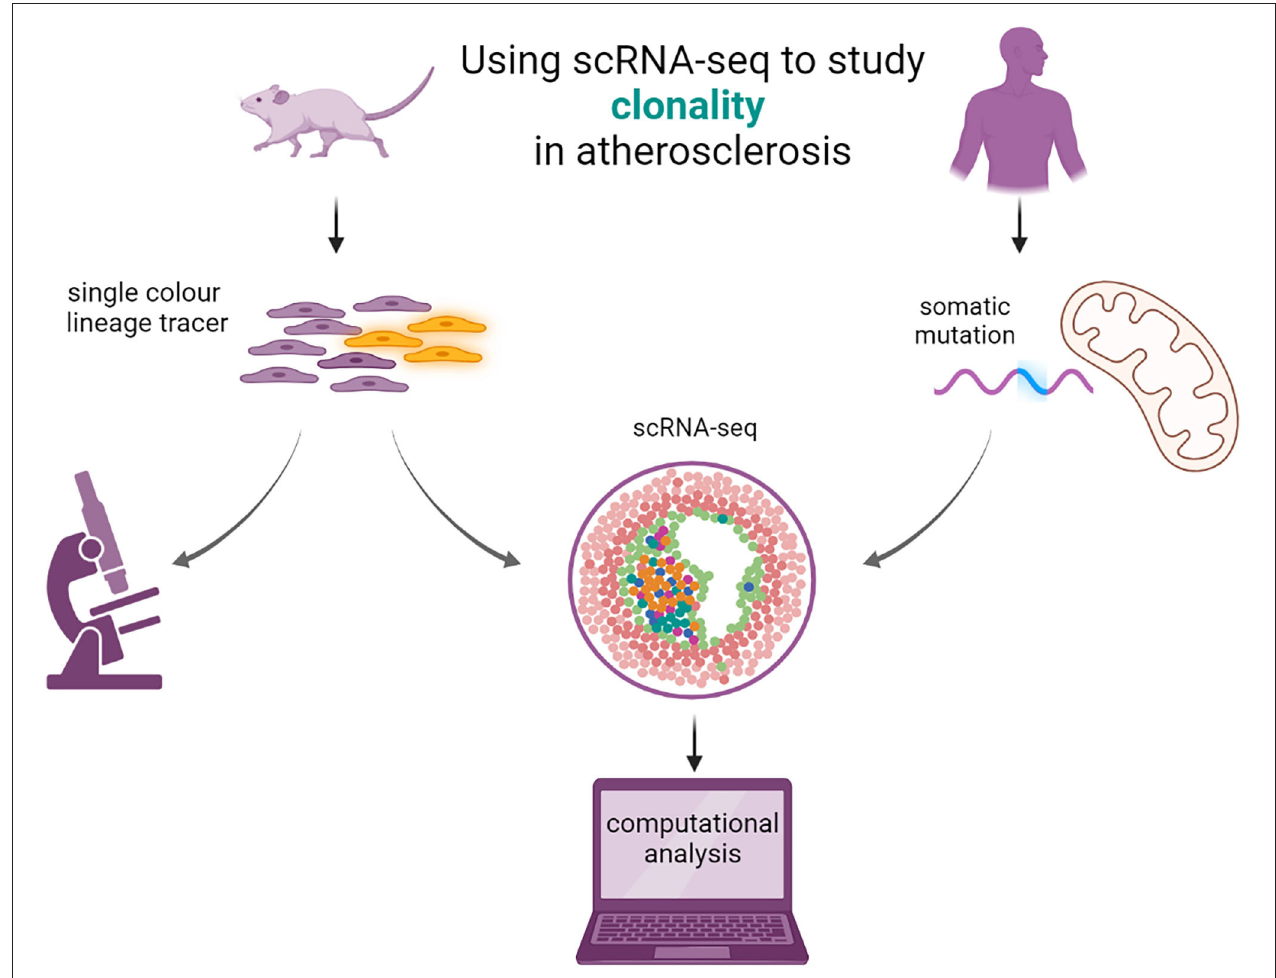
FIGURE 3 | Using scRNA-seq to study clonal cell expansion in atherosclerosis. Single color lineage tracers are added to reporter genes to study the clonality in mice (left). The mice will develop atherosclerosis and patches of clonal cells are visible from microscopy images. scRNA seq can be performed, and computational analysis can elucidate the transcriptomic properties of the cells expressing the lineage tracer. In humans (right), clonality can be imputed from studying the somatic mutations in mitochondria with scRNA- or scATAC-seq from existing data with computational analysis.